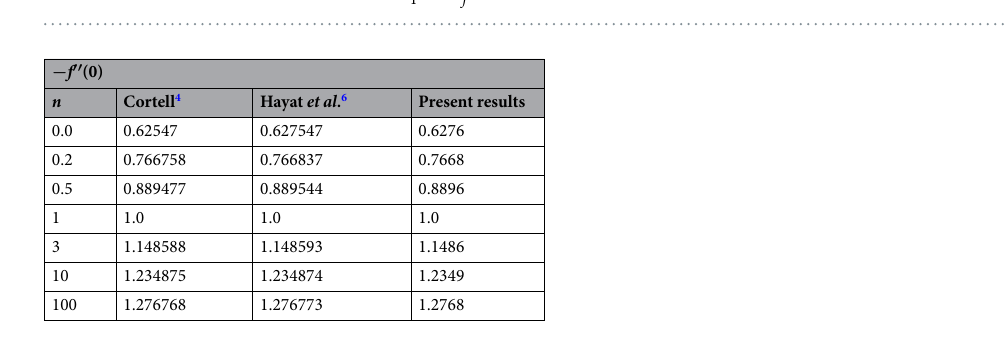
Table 2. Comparison of − ″ f (0) for different values of n with, β → ∞ , Bi → ∞